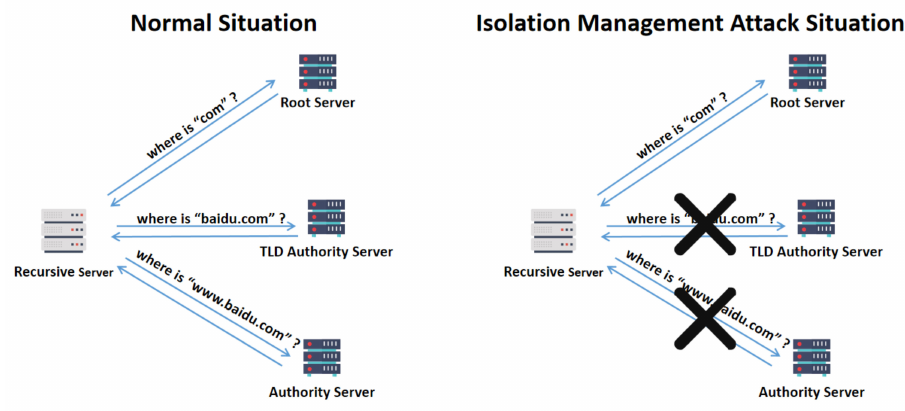
Figure 1. Isolated management